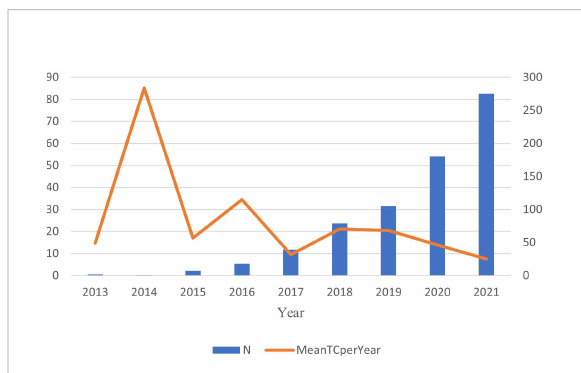
FIGURE 2 The annual scienti fi c production and average citations per year.